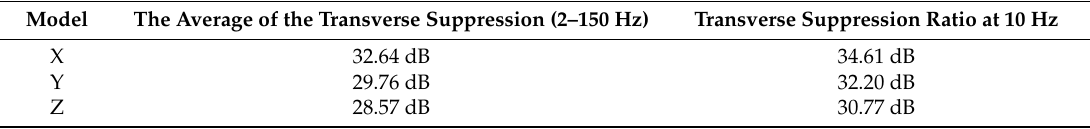
Table 2. Transverse suppression ratio test results for the geophone.